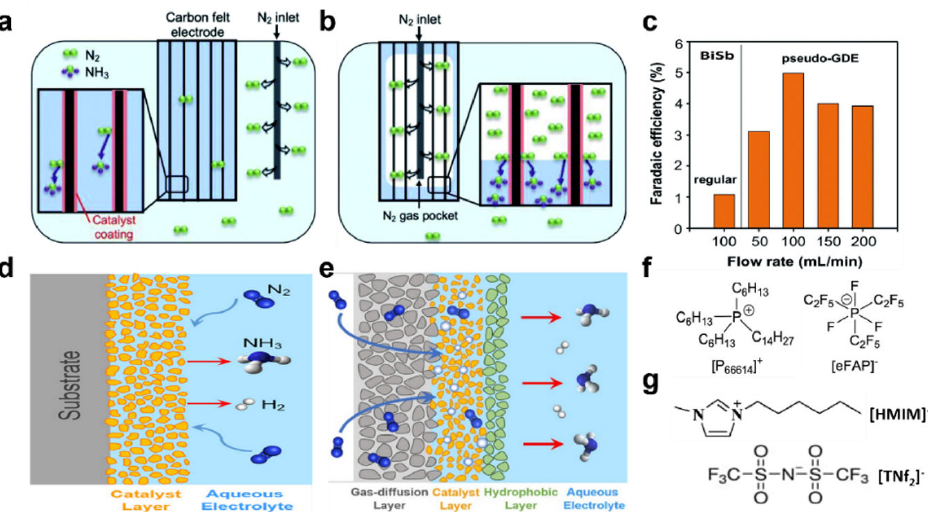
Figure 6. An illustration of ( a ) a regular electrode and ( b ) a pseudo-GDE. ( c ) FEs for 15 NH 3 of BiSb as a regular electrode and as a pseudo-GDE with various 15 N 2 flow rates at − 0.6 V RHE . Reproduced with permission [77]. Copyright 2021, Royal Society of Chemistry. Schematic illustration of two types of electrocatalytic interfaces for the ENRR. ( d ) Catalyst(s)-H 2 O(l) interface in H-cell. ( e ) Proposed N 2 (g)- catalyst(s)-H 2 O(l) interface in a flow cell with GDE. Reproduced with permission [20].